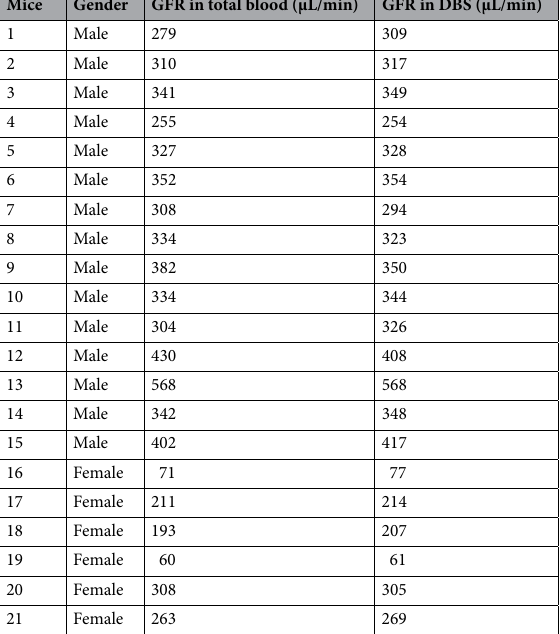
Table 1. GFR results with DBS compared with the reference method (total blood analysis).